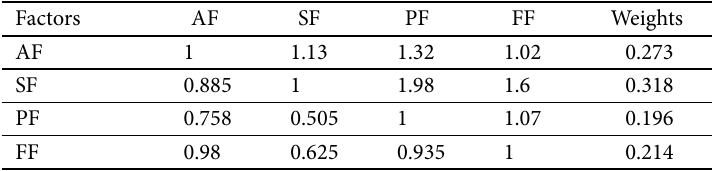
Table 4. Local weights and pairwise comparison matrix of factors